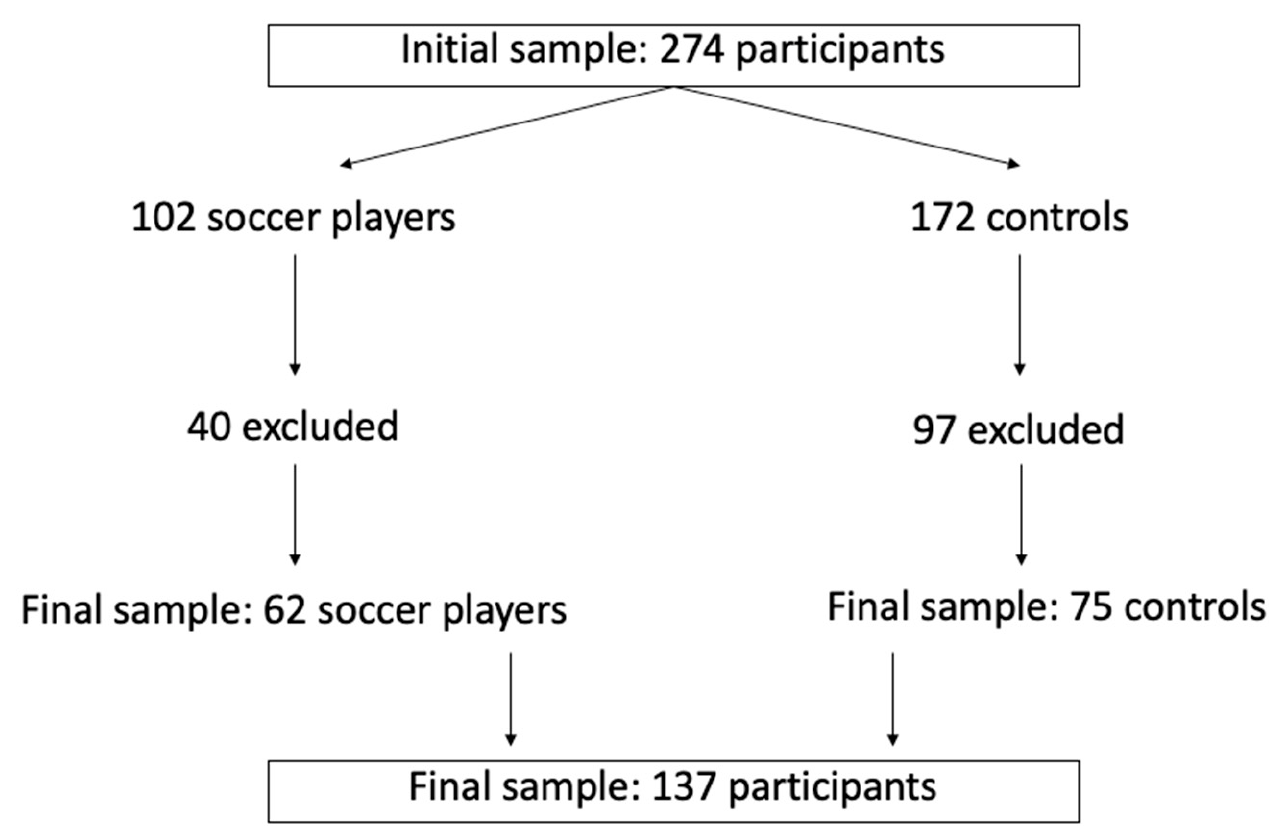
Figure 1. Flowchart presenting participants’ selection.